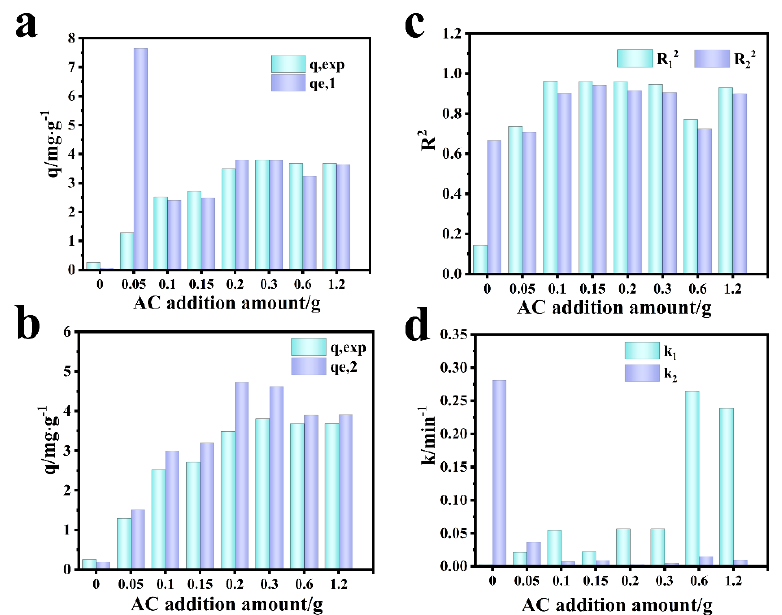
Figure 12. Comparison of simulation results of adsorption kinetics of RhB by the composite mem- brane. ( a ) First-order dynamics q e,1 vs. q exp . ( b ) Second-order dynamics q e,2 vs. q exp . ( c ) R 12 vs. R 22 . ( d ) k 1 vs. k 2